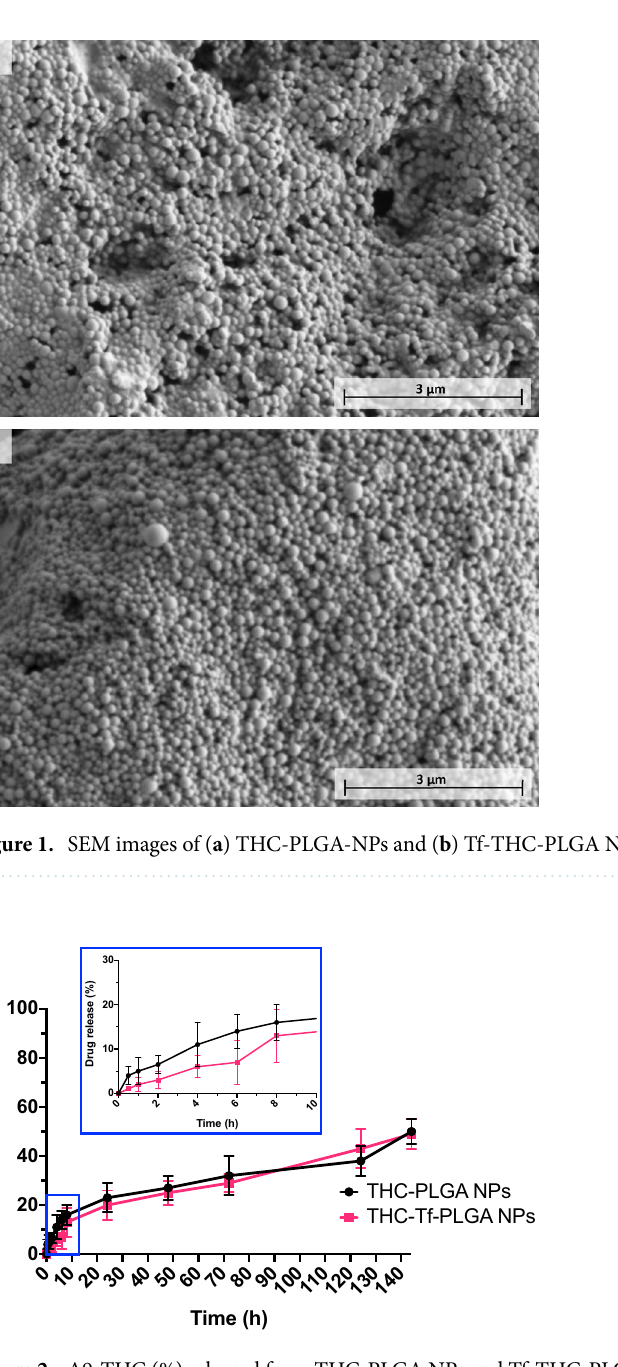
clathrin-dependent endocytosis inhibition (sucrose); (e) caveolae-dependent endocytosis inhibition (genistein); and (g) energy-dependent uptake inhibition (4 °C) respectively, representing the fluorescence intensity due to